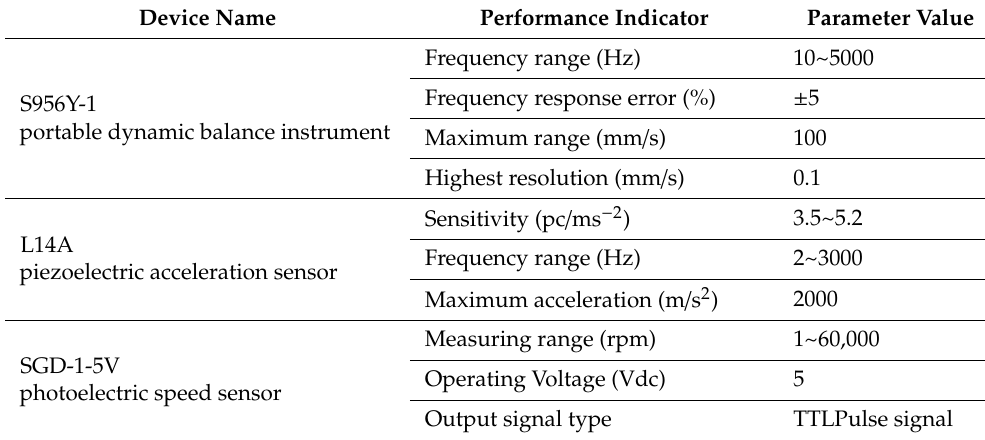
Table 1. Test instrument main performance